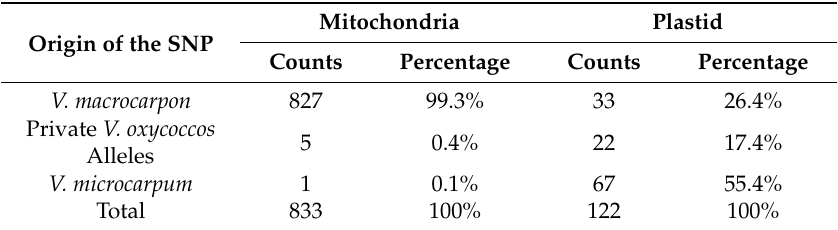
Table 2. Proportion of V. oxycoccos SNPs found in either V. macrocarpon , V. microcarpum , or that represent novel